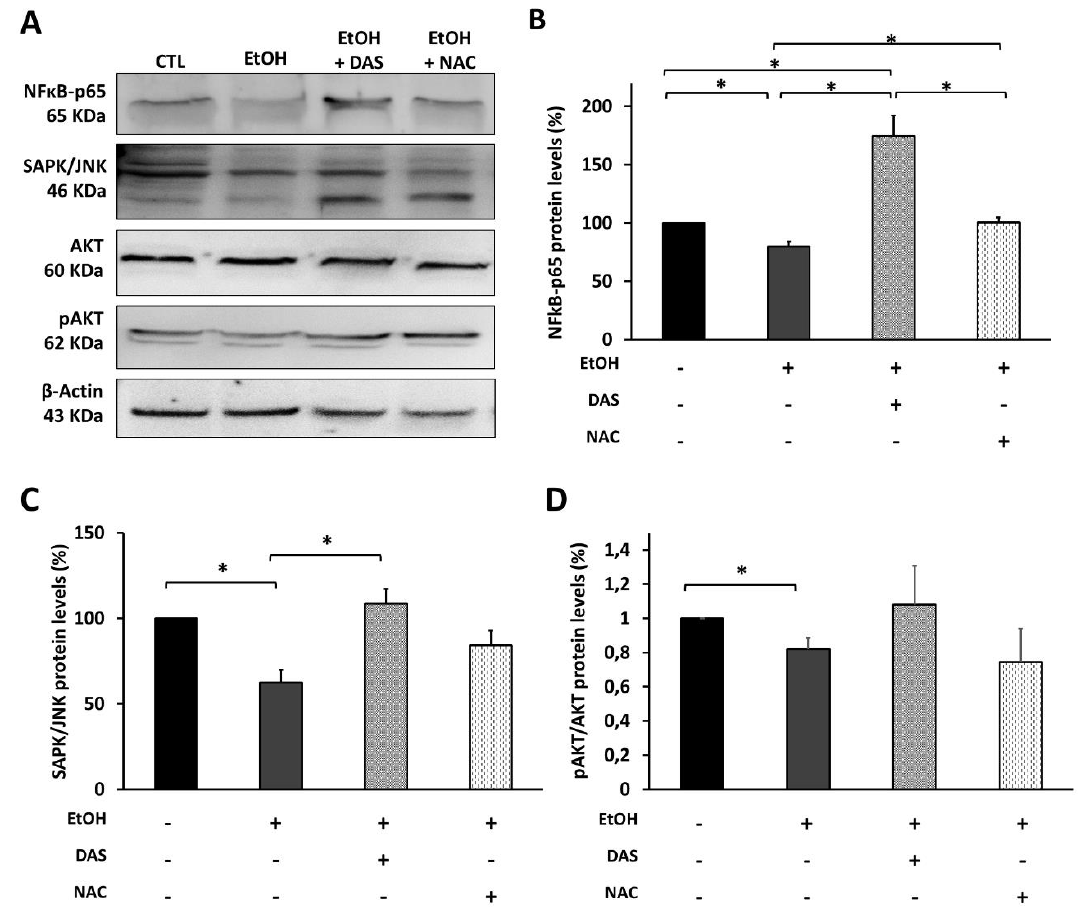
Figure 6. Upstream angiogenesis and inflammation biomarkers in ARPE-19 cells after EtOH treatment. ( A ) Representative pictures of protein levels quantification by WB of ( B ) p65-NFкB ( C ) SAPK/JNK and ( D ) pAKT/AKT ratio. Protein levels were normalized by β-actin. Values are expressed as mean ± SEM (N = 3). Statistically significant differences were set at * p < 0.05 vs.